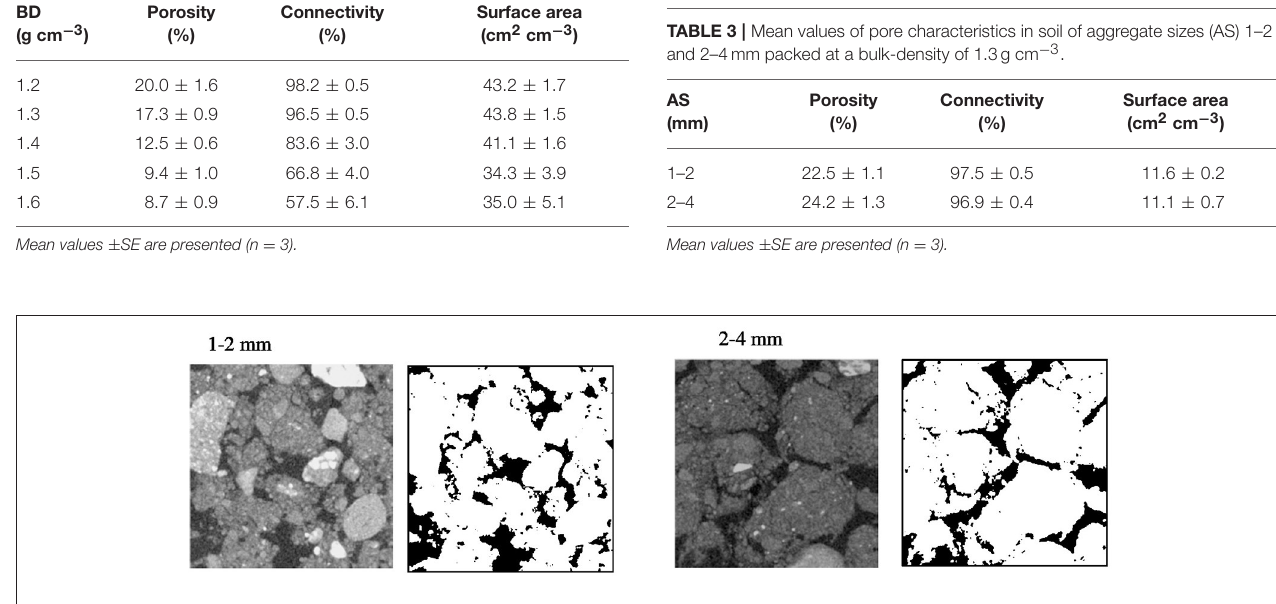
FIGURE 3 | Examples of segmented two-dimensional images of microcosms packed at BD 1.3g cm − 3 with aggregates sizes 1–2 and 2–4mm. The solid phase is represented by different gray-scales and through thresholding transformed into binary images with black representing the pores and white representing the solid